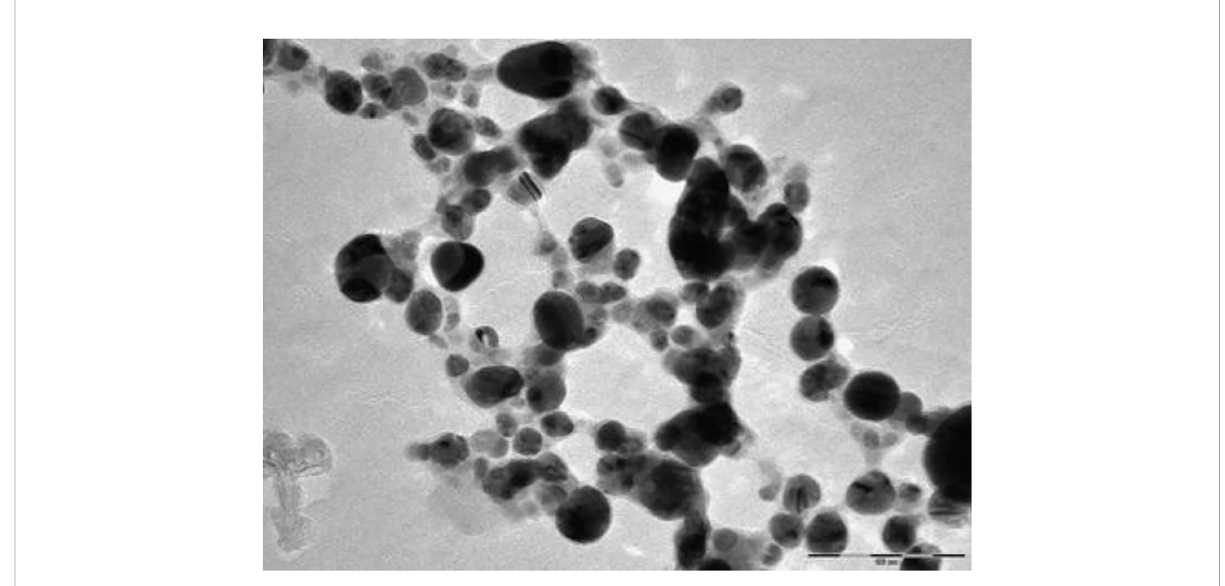
FIGURE 5 TEM image of copper ENMs (Engineered Nanomaterials) synthesized from algal extract of Bifurcaria bifurcata (Abboud et al., 2014). Copyright